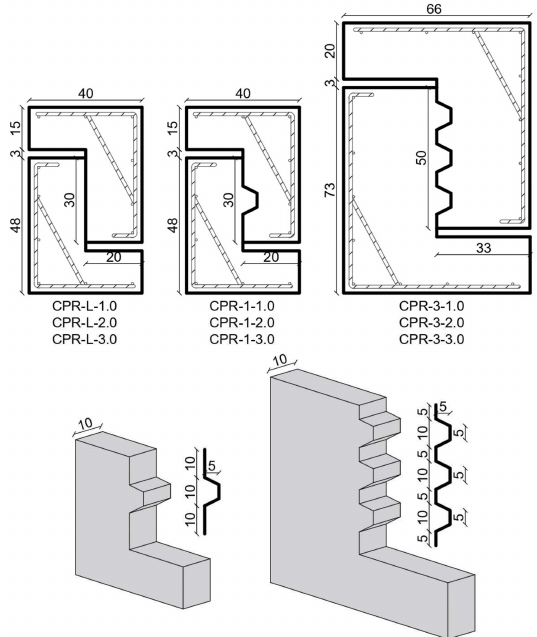
Figure 6. Dimensions and geometry of the dry joint specimens (units in cm).